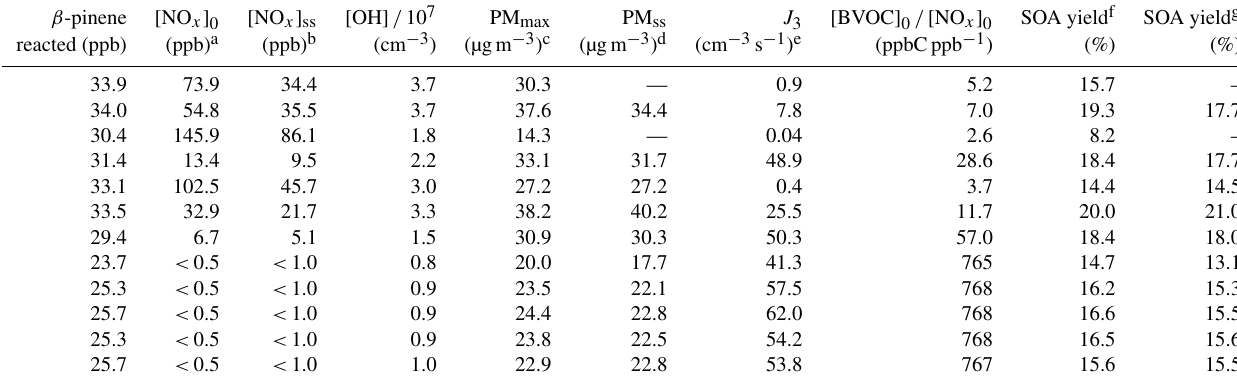
Table 1. Experimental conditions and results for β -pinene / NO x photooxidation experiments. β -pinene